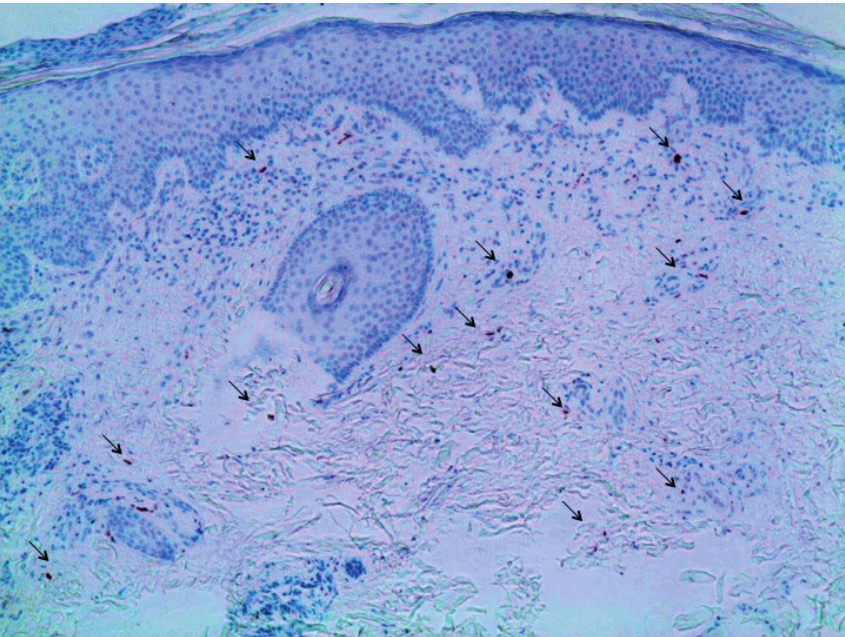
Figure 3. Immunohistochemistry of a skin biopsy obtained from the right thigh showing a mixed inflammatory infiltrate in the dermis with intermingled Interleukin 17 (IL17)-expressing cells (arrows). Furthermore, psoriasiform epidermal hyperplasia with hyperkeratosis and parakeratosis can be observed. Magnification